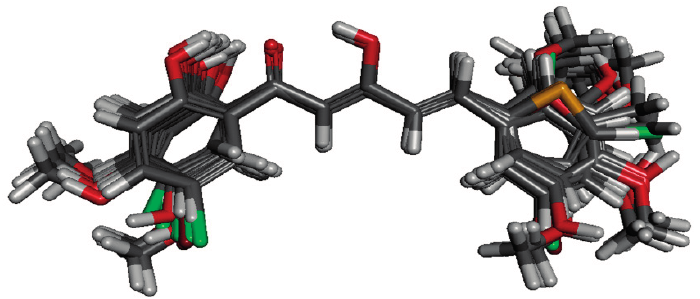
Figure 4. Structural alignment of the derivatives by template-based method according to the core of compound 88 .